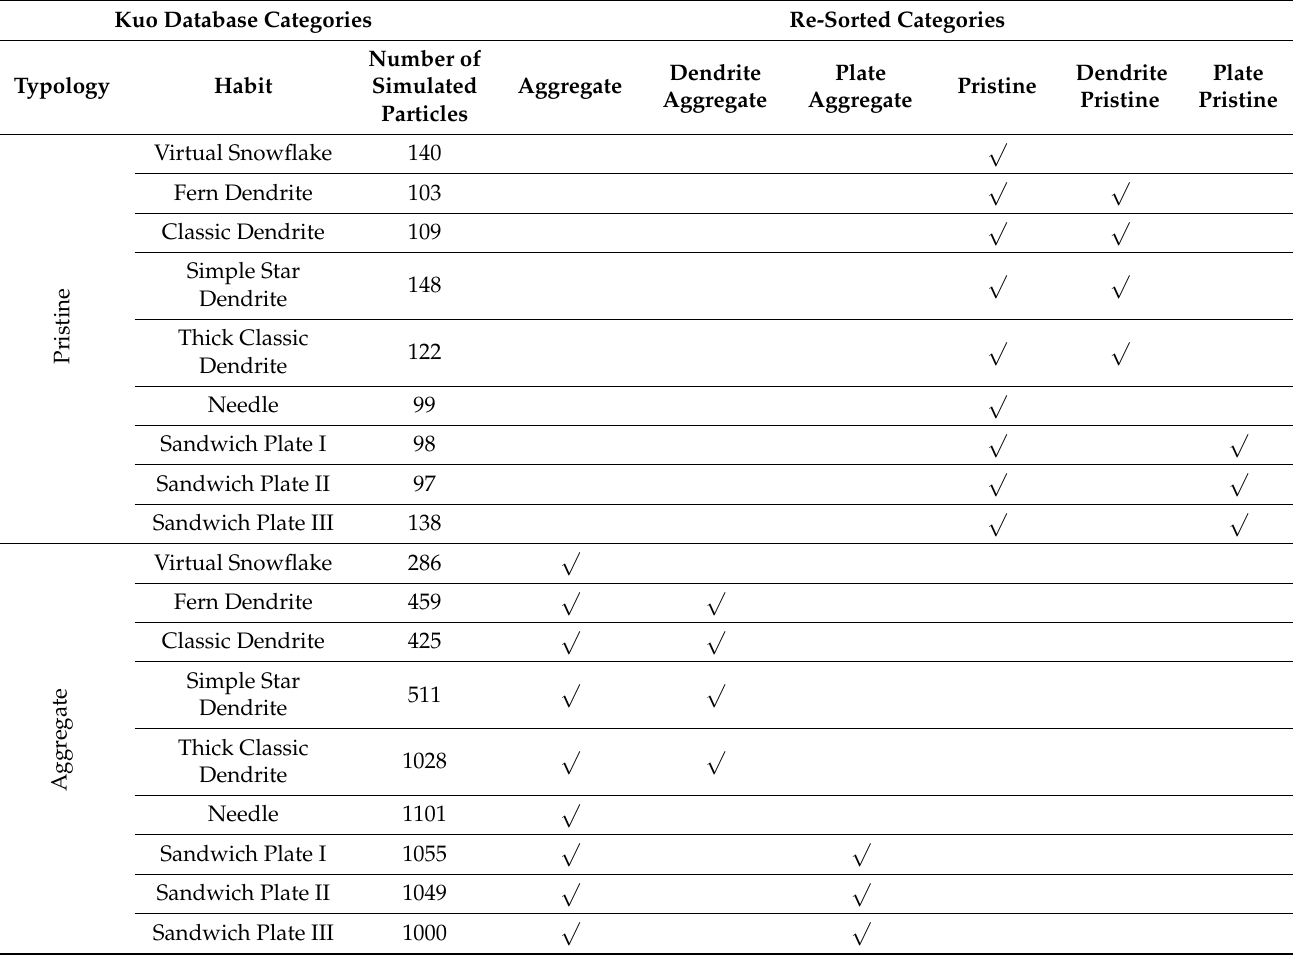
Table 1. Original hydrometeor categories of the Kuo database (on the left) and how they have been grouped to form the six snow categories used in this work (on the